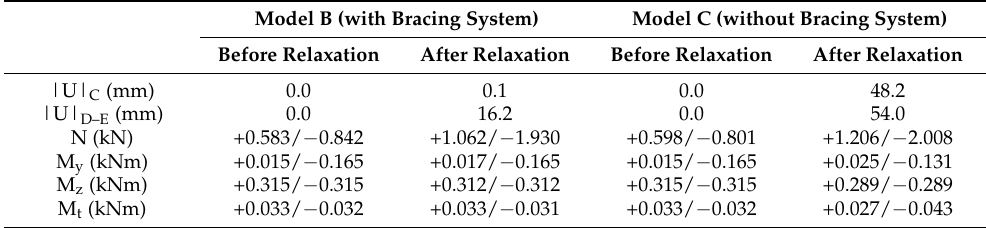
Table 11. Models B and C (with rigid connections). Displacements at control points C and D–E, and maximum axial force and moments in the longitudinal grid members due to the construction process, before and after relaxation.